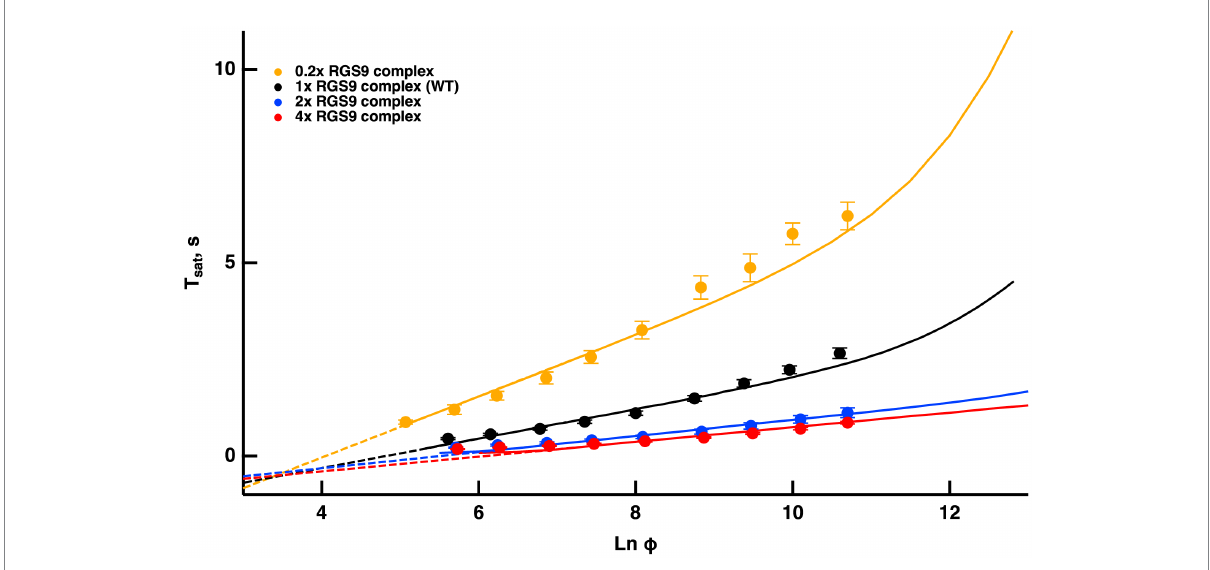
FIGURE 3 Fits of the model to experimental results of mouse rods with different expression levels of the RGS9 complex. For modeling, levels of RGS9 complex in the mutant rods were changed to 0.2x, 2x and 4x that of WT. Experimental results for R9AP+/ − , R9AP75 and R9AP138 lines of mice were from Burns and Pugh (2009) . T sat was measured from mid-flash to 10% recovery. Continuous lines show the fits with the model, where the linear portions of the relations were extended with dashed lines to show that they intersect near T sat =